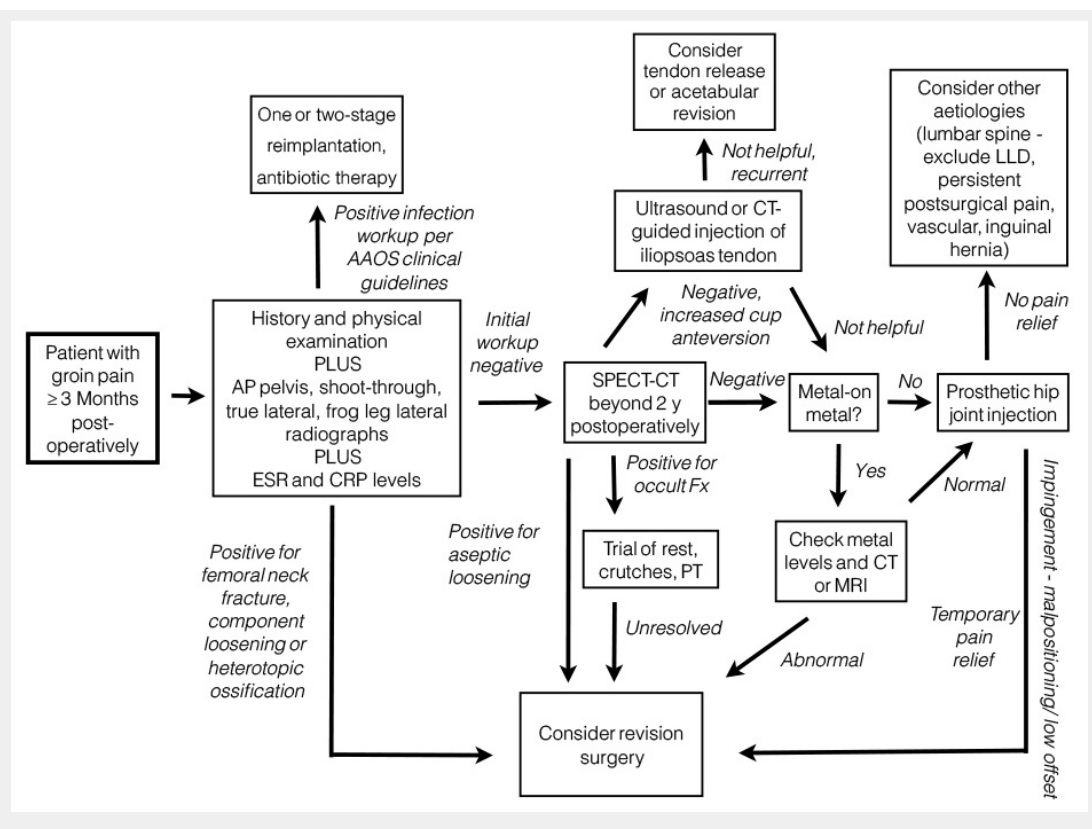
Figure 3 Diagnostic algorithm for groin pain after total hip replacement [93, 94]. AAOS = American Academy of Orthopedic Surgeons; AP = anteroposterior; CRP = C-reactive protein; CT = computed tomography; ESR = erythrocyte sedimentation rate; LLD = leg-length discrepancy; MRI = magnetic resonance imaging; PT = physiotherapy; SPECT = single photon positron emission computed